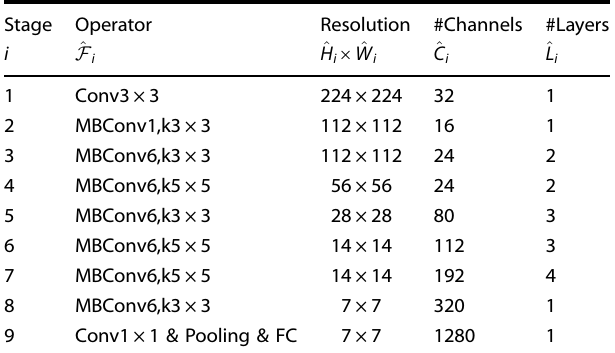
Table 6. The structure of Ef fi